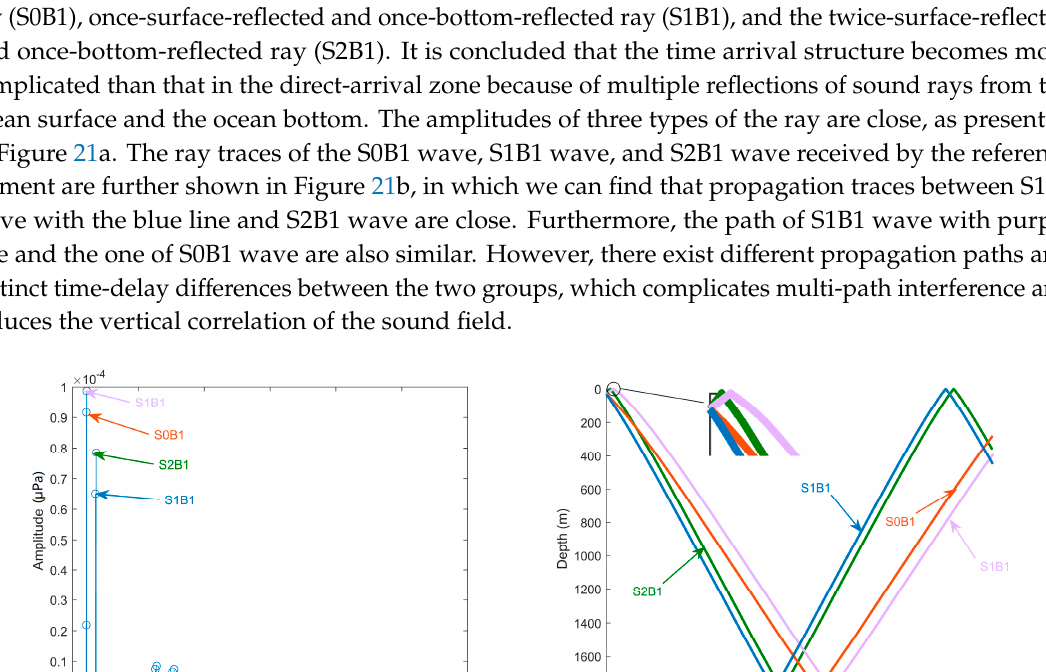
Table 2. Structure of S1B1, S0B1, and S2B1 wave.